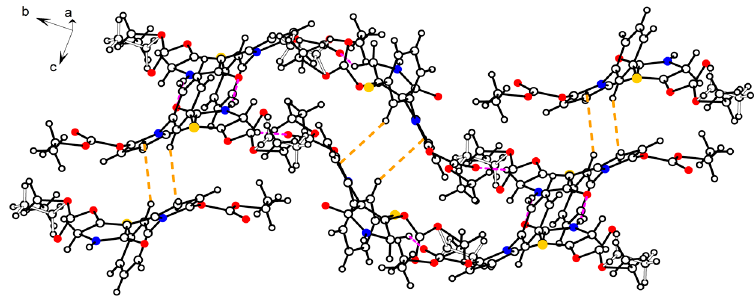
Figure 3. Crystal parking diagram of compound 6b . Dashed lines show the C-H··· π interaction.